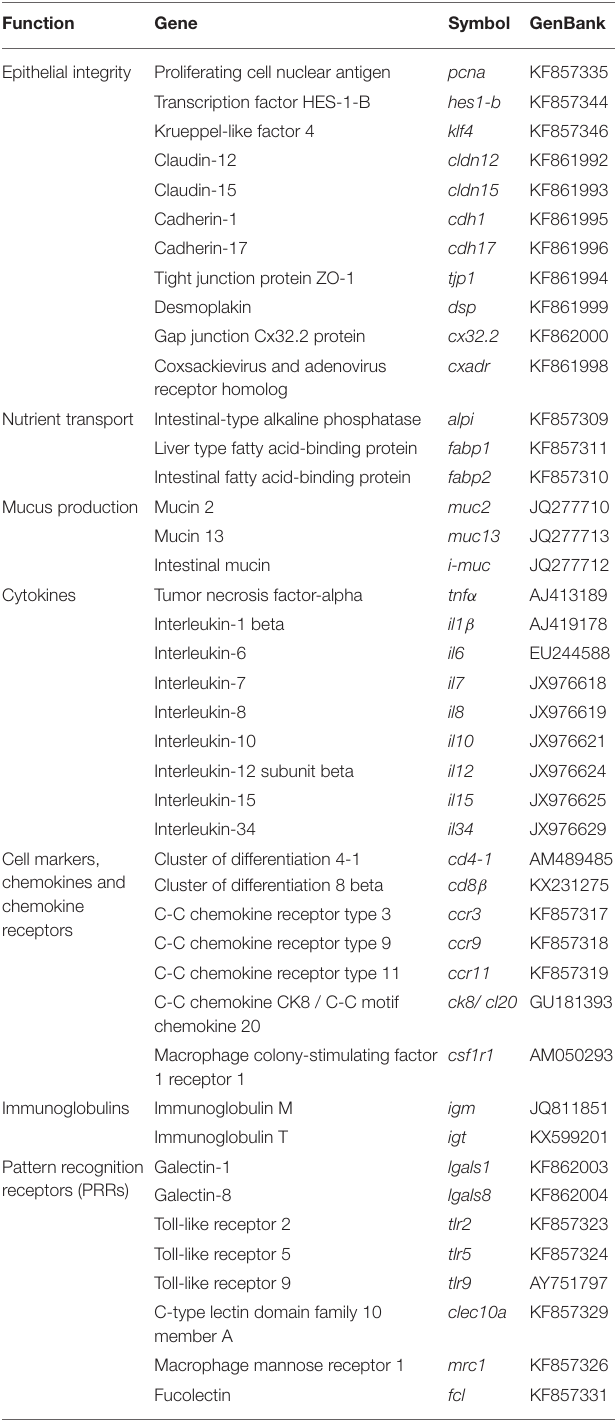
TABLE 2 | Polymerase chain reaction (PCR)-array layout for intestine gene expression profiling in sea bream. Function Gene Symbol GenBank Epithelial integrity Proliferating cell nuclear